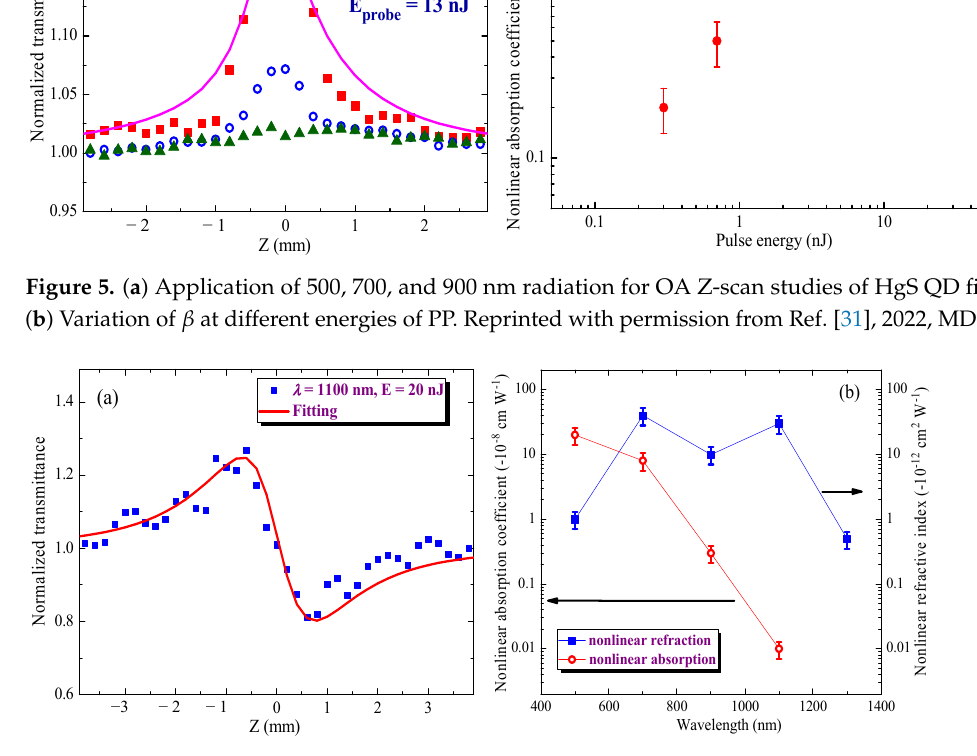
Figure 6. ( a ) Negative nonlinear refraction in the case of 1100 nm, 20 nJ, 150 fs PP. ( b ) Variations of β sat and γ along the studied spectral range. Reprinted with permission from Ref. [31], 2022, MDPI. Below, the nonlinear optical studies of the HgS QDs suspensions and films using nanosecond pulses are discussed. The longer PPs allowed observation of the replace- ment of the SA by the RSA in the extended (0.2 mm) medium (Figure 7a). The application of 532 nm pulses led to even stronger modification of the nonlinear absorption in this sample (Figure 7c). The scans shown in Figure 7c were fitted by standard procedure [33,34] to determine the corresponding SA and RSA processes ( β sat = − 6 × 10 − 8 cm W − 1 and β RSA = 5 × 10 − 7 cm W − 1 ). A similar parameter in the case of 1064 nm PP was derived using the same procedure ( β sat = − 4 × 10 − 9 cm W − 1 ). The application of relatively strong laser pulses (0.85 mJ) allowed observation of the nega- tive nonlinear refraction of sample at λ = 1064 nm (Figure 7b, γ = − 1 × 10 − 13 cm 2 W − 1 ). The self-defocusing at 532 nm was observed at the rather small energy of PP (0.005 mJ), thus deter- mining the large value of the nonlinear refractive index (Figure 7d, γ = − 6 × 10 − 13 cm 2 W − 1 ). Below, I discuss the THG studies using the 1100 nm radiation. The intensity of the third harmonic (TH) from the 0.15 mm thick glass plate was more than one order of magnitude smaller than the thin (70 nm) film of HgS QDs deposited on the glass plate. The TH yield from thin film was calculated to be at least 4 × 10 7 times larger compared with TH yield from the pure glass substrate of similar thickness.